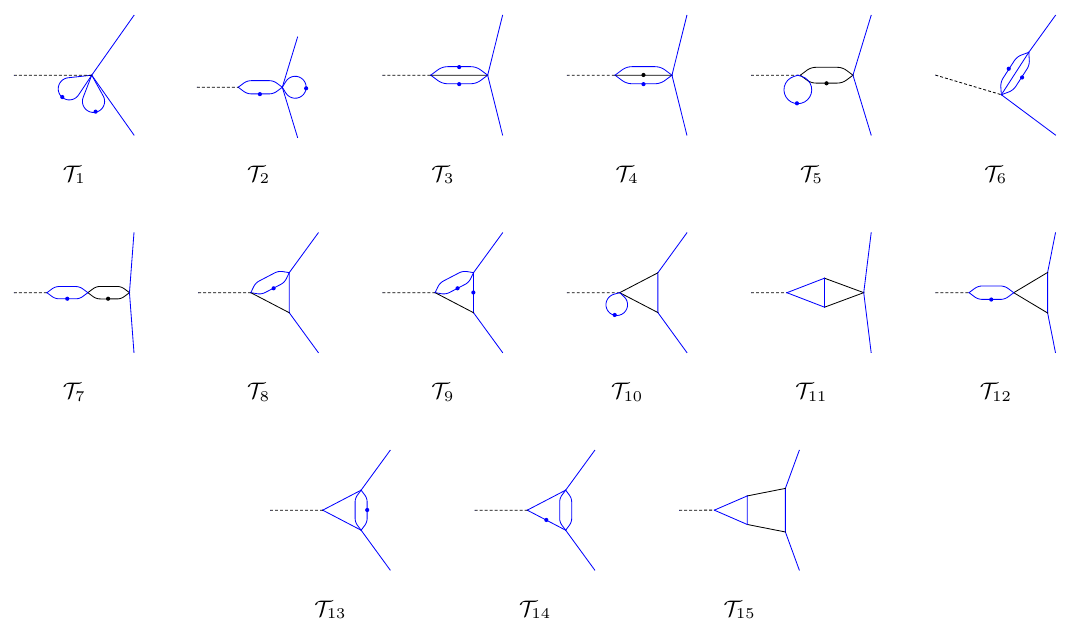
Figure 6. Master integrals required for the evaluation of the scalar and pseudo-scalar form factors, corresponding to the two-loop diagrams in figure 1, in the equal-mass case. In each diagram, we indicate the off-shell external mediator (dashed lines), massive fermions with mass m (blue lines), massless photon (black lines) and squared denominators